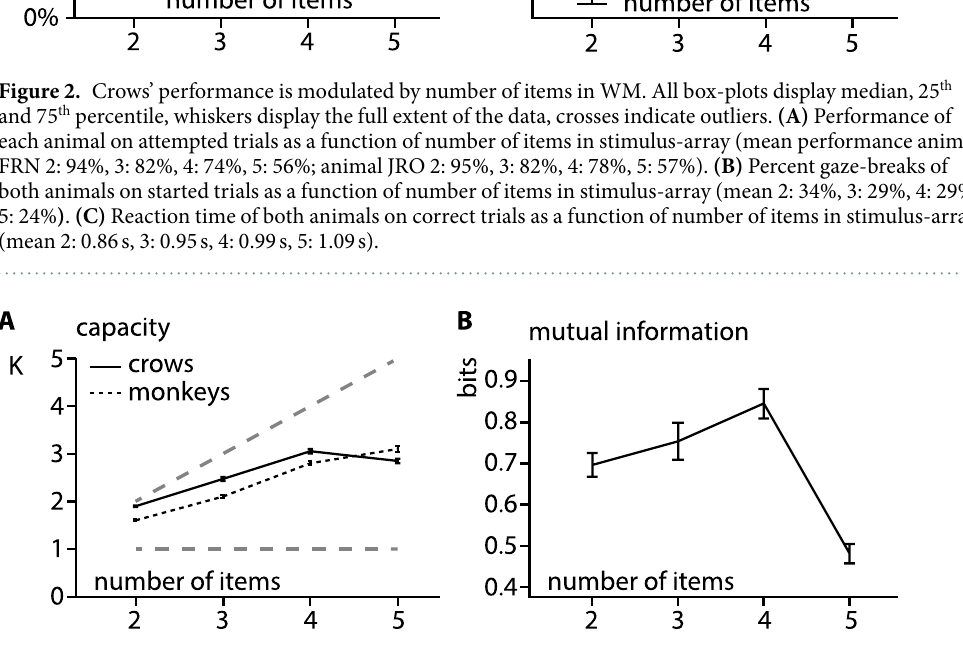
Figure 3. Capacity of WM is comparable between crows and primates. (A) Capacity K as a function of number of items in stimulus-array. Solid black line depicts capacity of both crows, dotted black line depicts capacity of both monkeys (data published in 46 ). Grey dashed lines depict chance-level and optimal performance. Error- bars are SEM. (B) Mutual information of both crows as a function of number of items in stimulus-array. Information about stimulus-array increases until capacity is exceeded (4–5 items) at which point there is a loss of information. Error-bars are